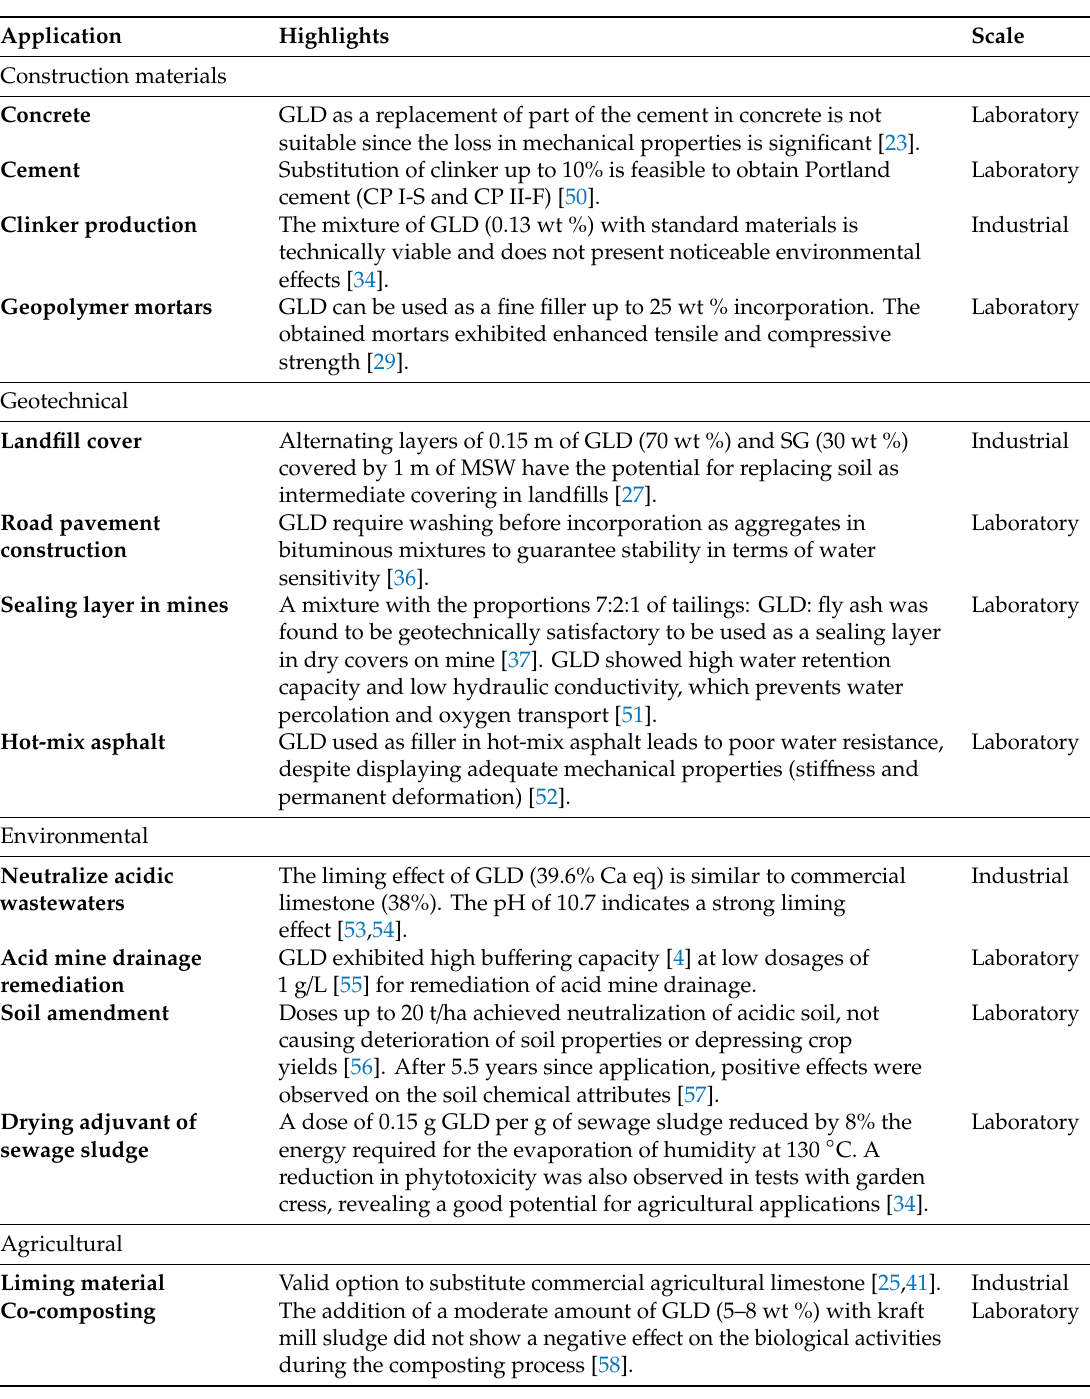
Table 6. Applications of GLD reported in the